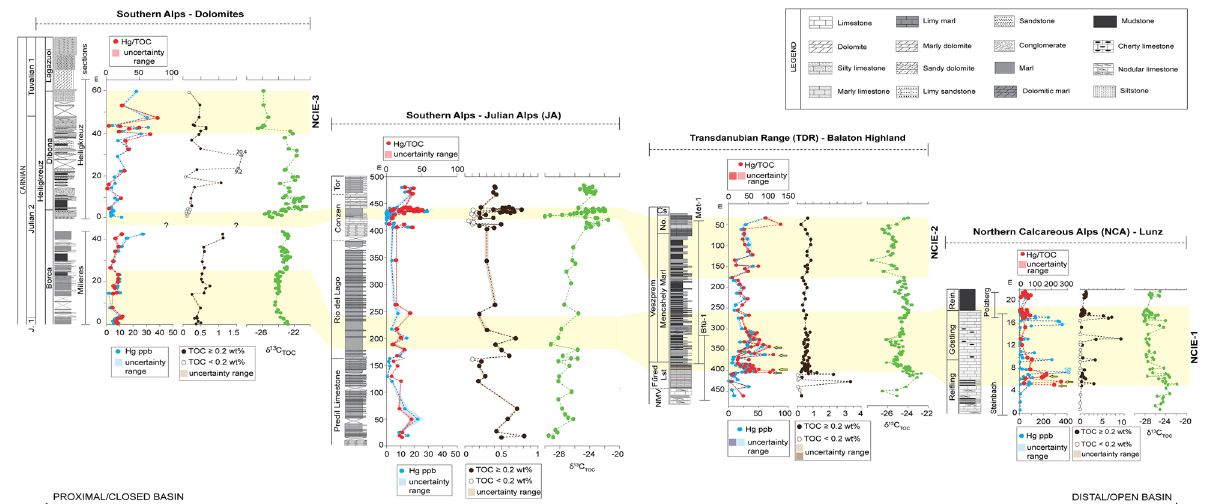
Figure 3. Hg, Hg/TOC, and C-isotope data from the Western Tethys. Hg has been normalized for TOC > 0.2 wt% (Fig. 2). C isotope data and stratigraphic correlations are from ref. 6–8 . The 10% Hg concentration uncertainty is indicated on each Hg data plot in the form of shaded, semitransparent bounds; the ± 0.02 wt% uncertainty on TOC measurements is also shown by semitransparent bounds; and the uncertainty envelope for each Hg/TOC value is shown on each Hg/TOC plot by a pale red field. Note that the TOC uncertainty bounds are visible only for section Julian Alps (JA) at this scale. The yellow arrows indicate the onset of Hg/TOC peaks in the NCA and TDR before and through the facies